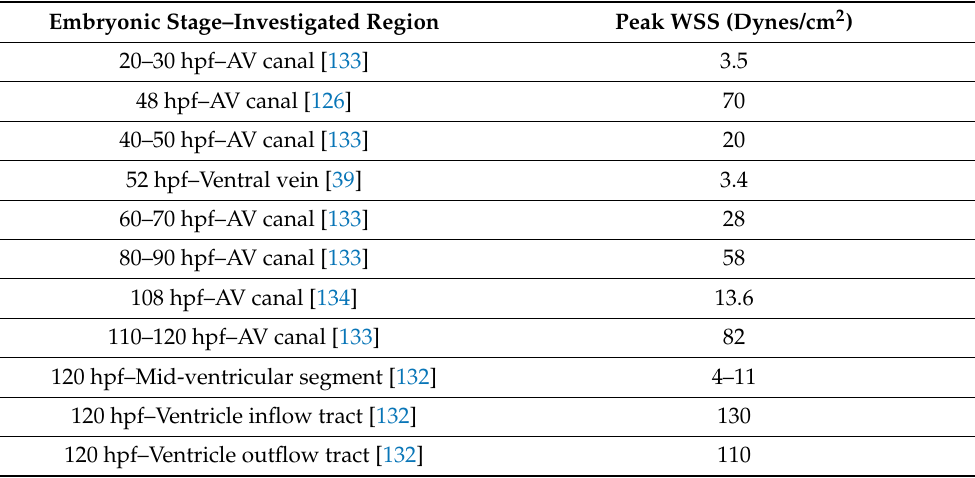
Table 2. WSS levels in normal zebrafish embryos for various developmental stages (AV canal: atrioventricular